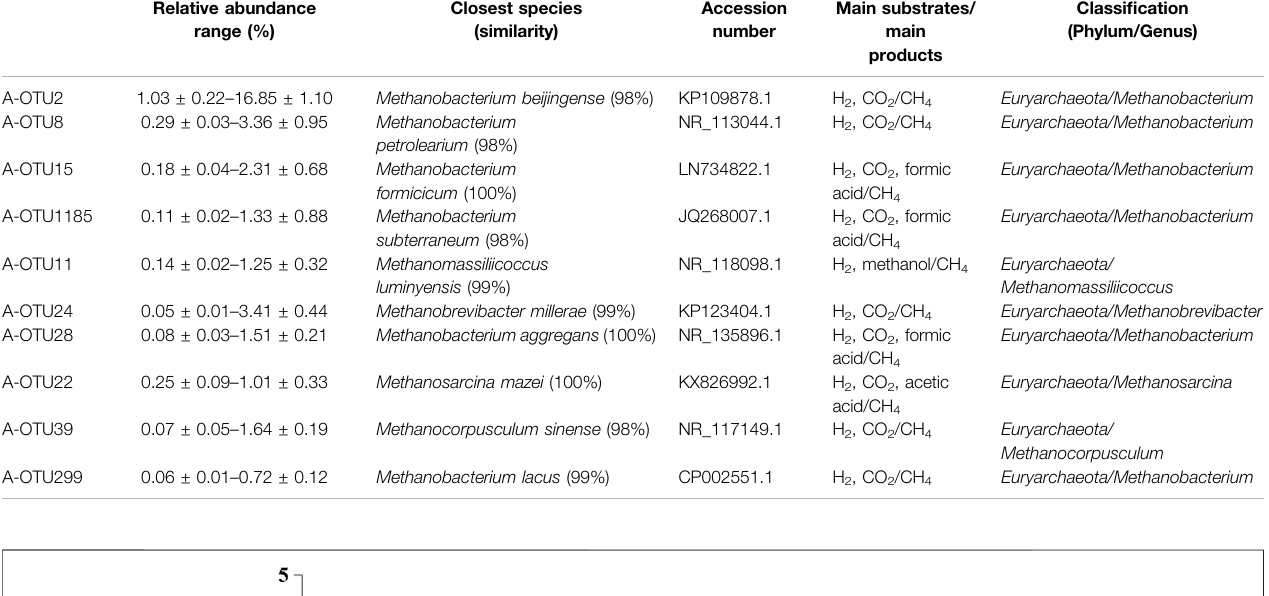
TABLE 4 | The classi fi cation and function information of the most dominant 11 methanogenic archaeal species. Relative abundance range (%)